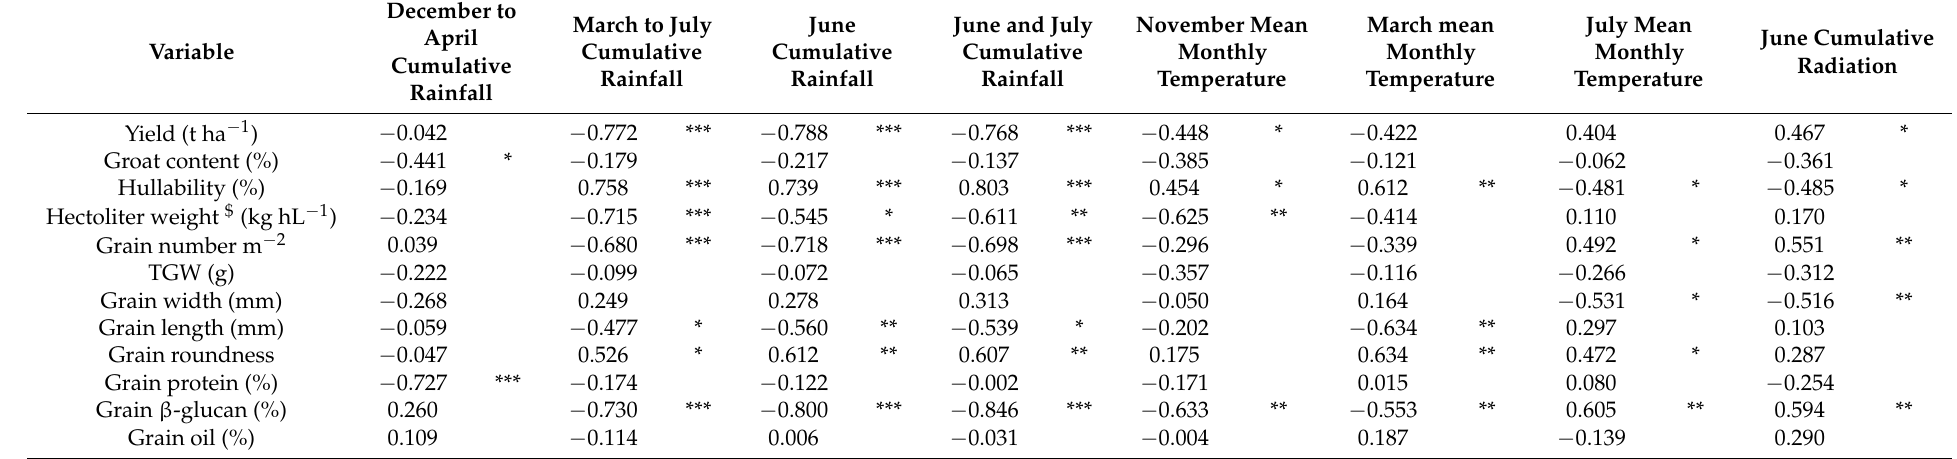
Table 6. Pearson correlation coefficients between rainfall (mm) and site means for grain yield, quality and composition (excluding spring sown trial, environment